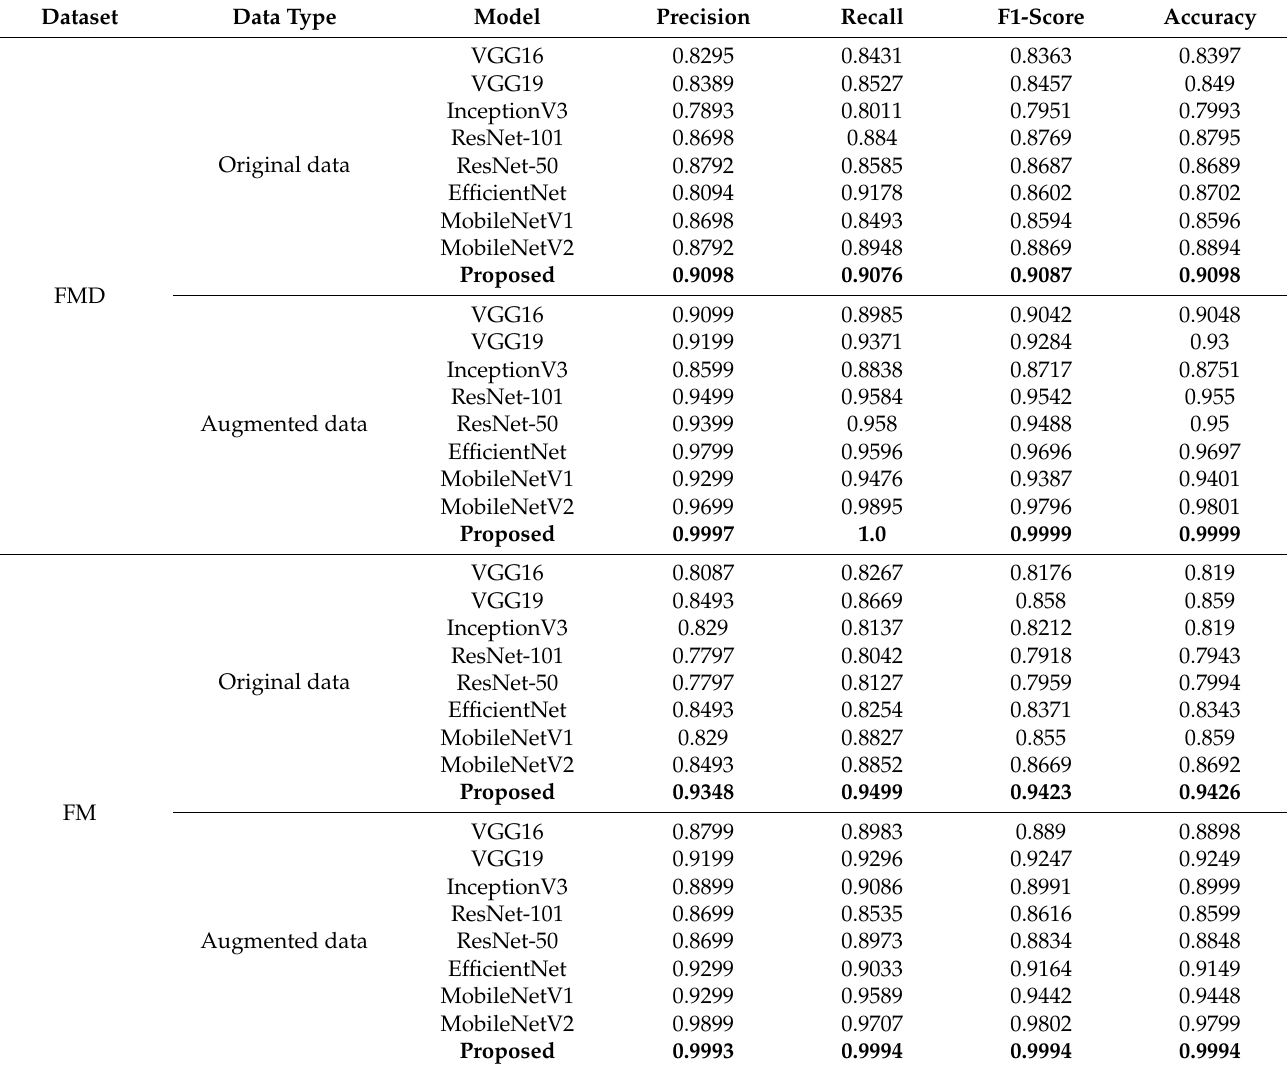
Table 5. The detailed comparative analysis of different models for face mask